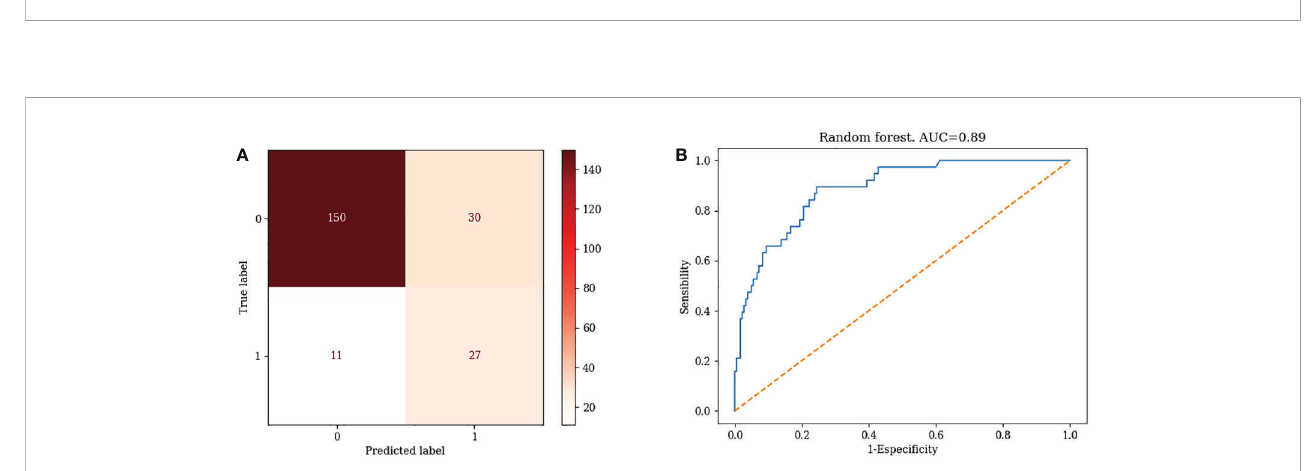
FIGURE 3 Confusion matrix and ROC curve of Random Forest algorithm.